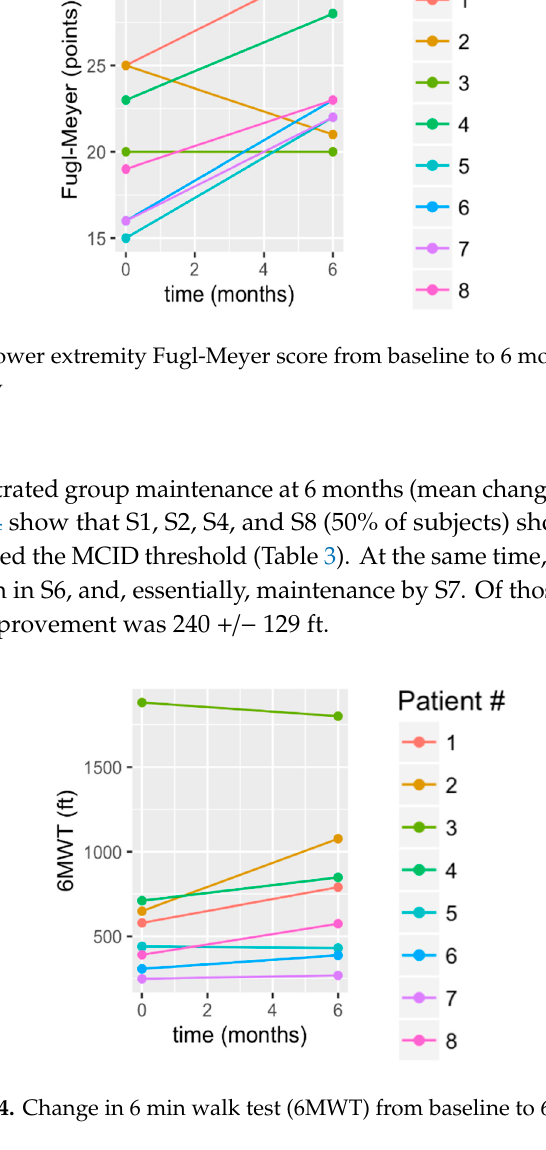
Figure 2. Change in Berg Balance Scale (BBS) from baseline to 6 months. S2 and S4 had identical baseline and 6 month scores, which is why S2’s data are obscured beneath S4’s data.